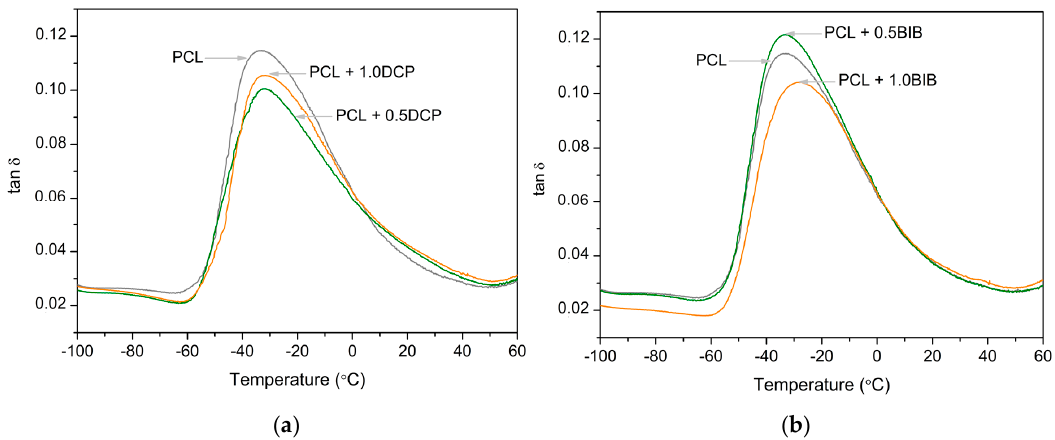
Figure 5. Storage Modulus for PCL modified by DCP ( a ) and PCL modified by BIB ( b )